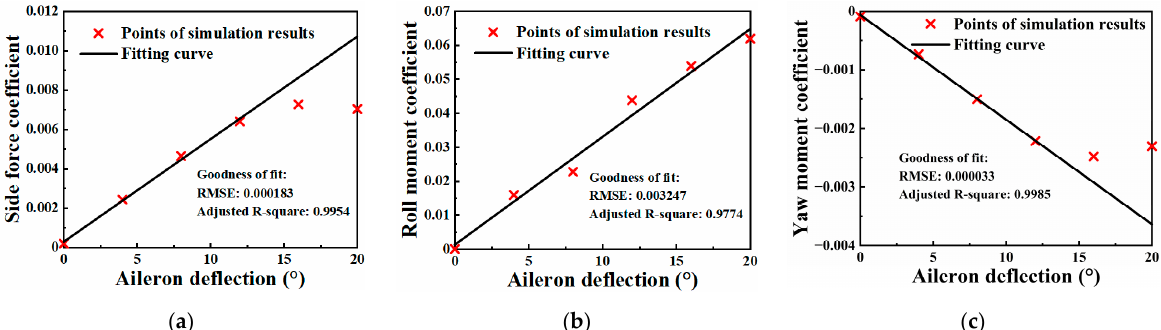
Figure 5. Curve fitting of aerodynamic coefficients versus the aileron deflection: ( a ) side force; ( b ) roll moment; ( c ) yaw moment.